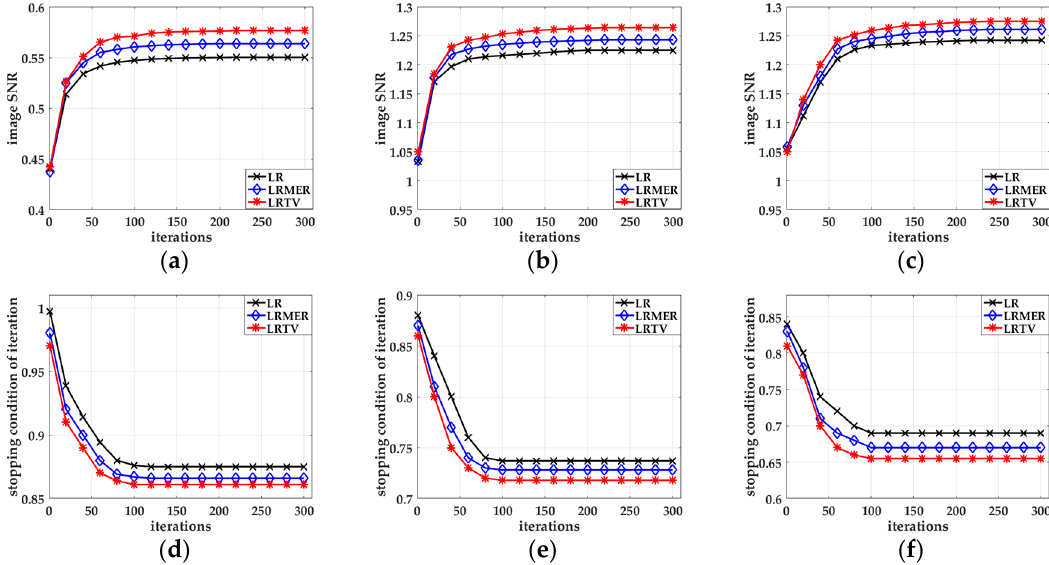
Figure 6. ( a ) Image signal-to-noise ratio (SNR) curve of LR, LRTER and LRTV when “hands prolapse”; ( b ) Image SNR curve of LR, LRTER and LRTV when “shoulder abduction”; ( c ) Image SNR curve of LR, LRTER and LRTV when “hands held”; ( d ) Termination condition of iteration of LR, LRTER and LRTV when “hands prolapse”; ( e ) Termination condition of iteration of LR, LRTER and LRTV when “shoulder abduction”; ( f ) Termination condition of LR, LRTER and LRTV when “hands